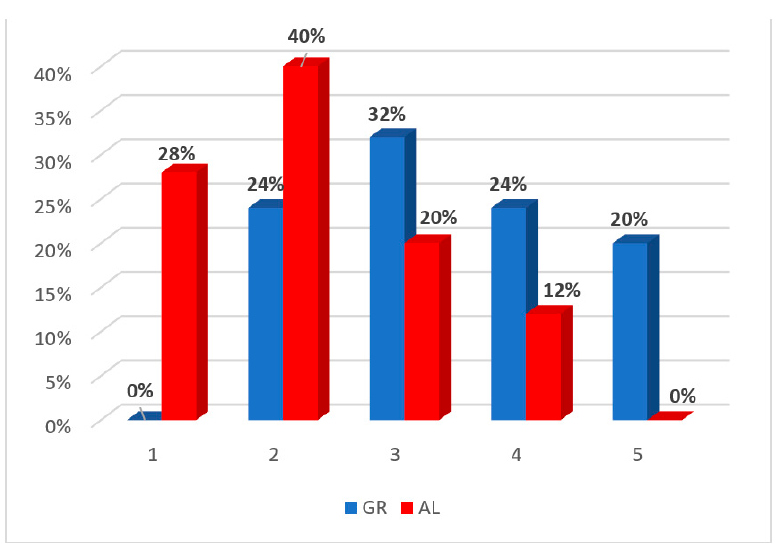
Figure 3. Contribution of the experience gained in the business acceleration program to the devel- opment of more than one business ideas.